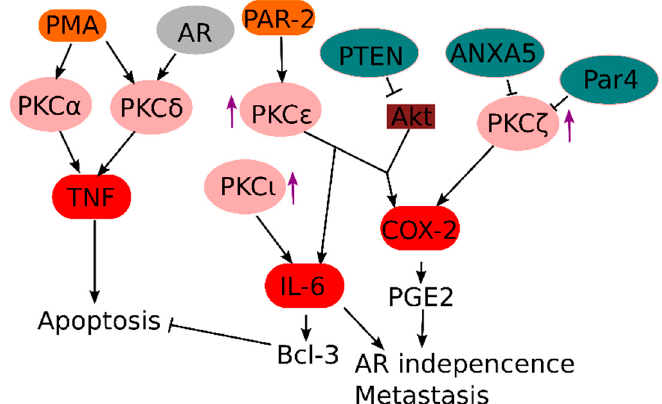
Figure 3. Overview of the role of PKC-dependent signaling in prostate cancer. PMA-induced activation of both PKC α and PKC δ has been associated with prostate cancer cell apoptosis due to autocrine TNF production, whereas elevated expression (arrow pointing up) of the other PKCs is associated with survival and aggressiveness of prostate cancer via multiple other mechanisms (see text for details). At least one of the pro-oncogenic PKCs (PKC ε ) can also be activated by upstream signaling.